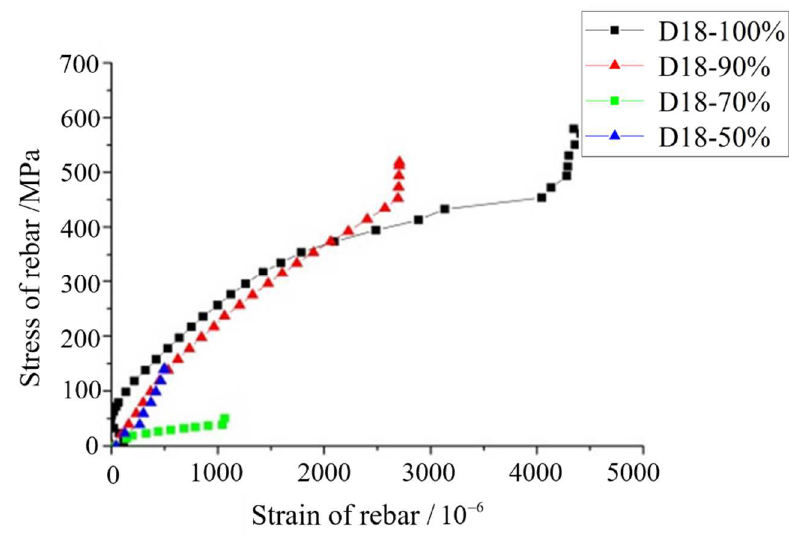
Figure 11. Rebar stress-strain curves for D 18 connectors with different compactness.